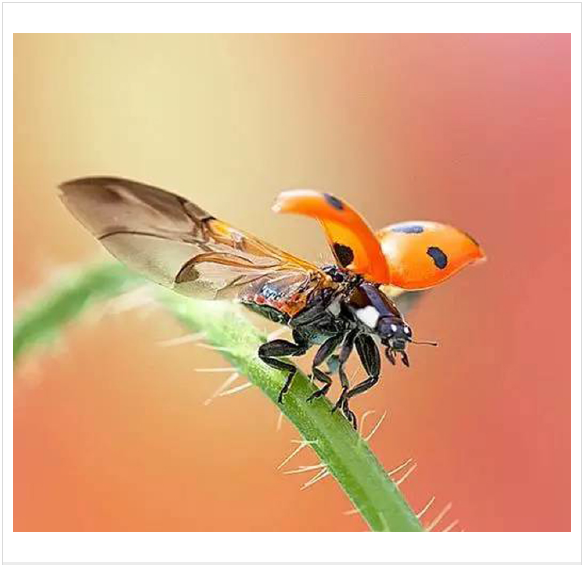
Figure 1: The moment of unfolding of H. axyridis hindwings.